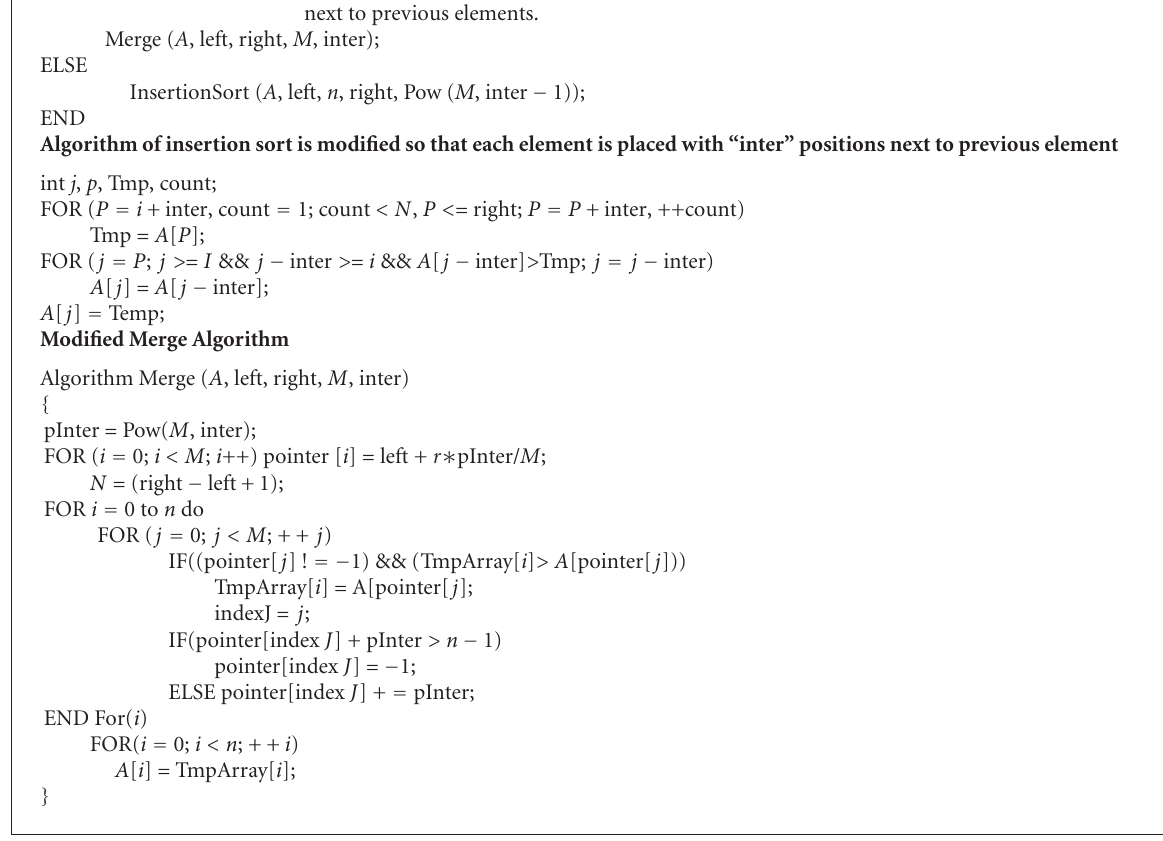
Algorithm 1: Modified